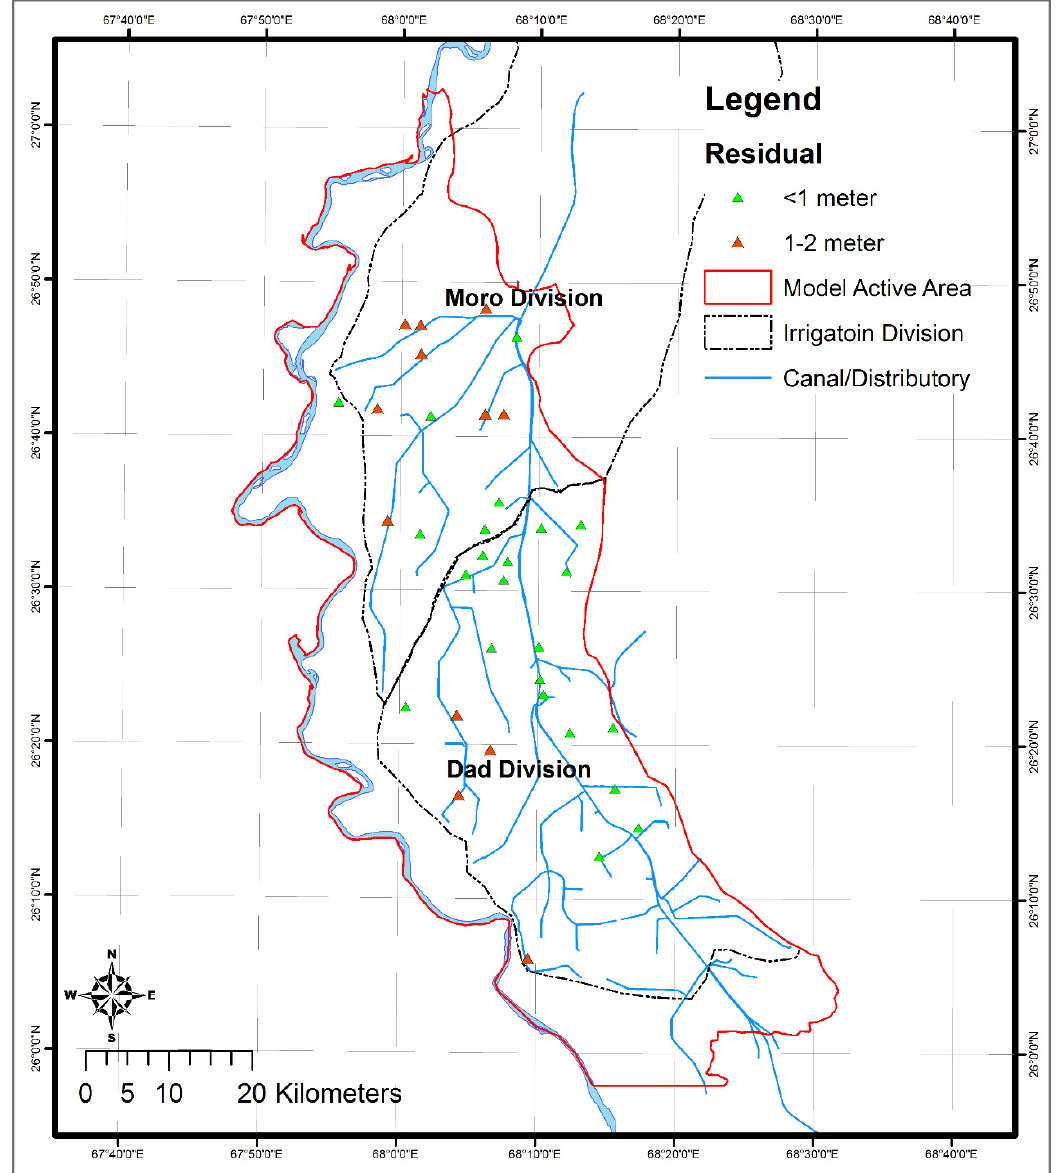
Figure 8. Residuals (observed minus simulated heads) at the end of the model calibration.